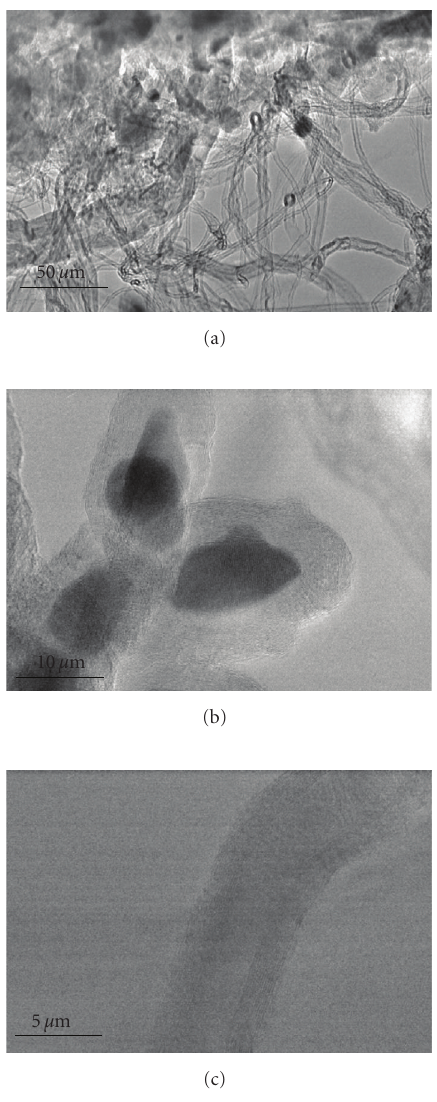
Figure 10: TEM images of carbon nanostructures observed for samples with iron deposition carried out via electrochemical